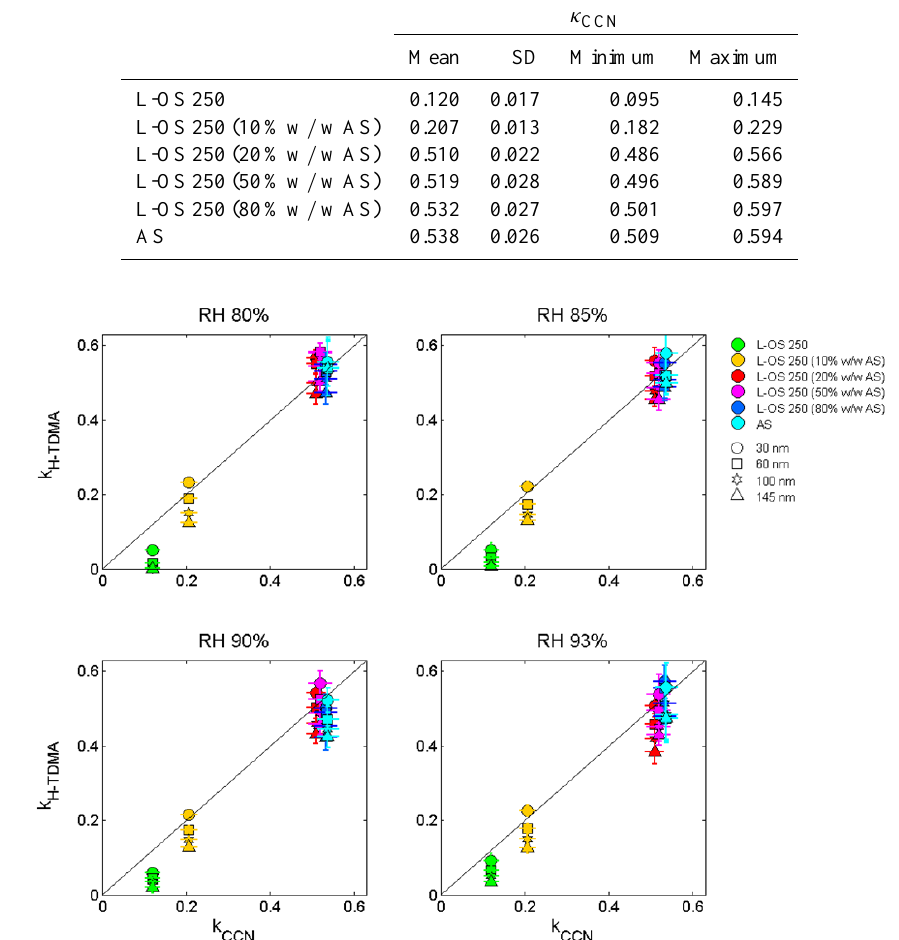
Figure 8. Hygroscopicity parameter, κ , derived from the H-TDMA measurements, plotted against κ obtained from the CCN measurements, for six mixtures of L-OS 250 and AS. A mean κ value for each composition was found for the CCN-derived κ and error bars denote the experimental uncertainty as explained in Sect.